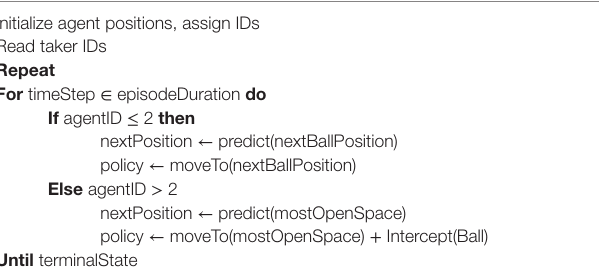
algOriThM 1 | Taker Team Heuristic